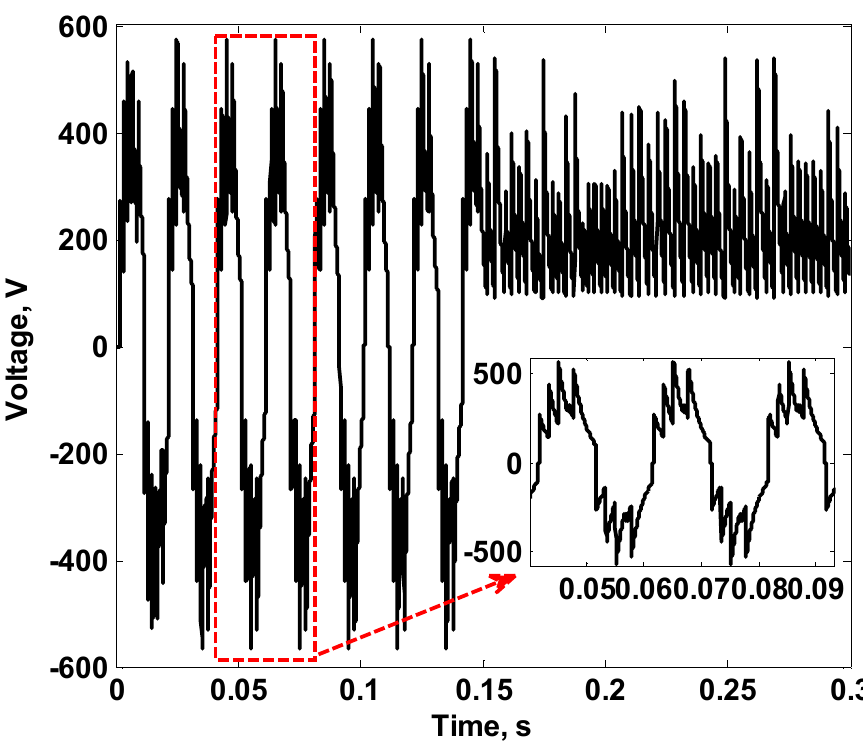
Figure 32. Conditions of 220 V, 50 Hz with a Transfer to a DC Signal of 200 V at 0.15 s.